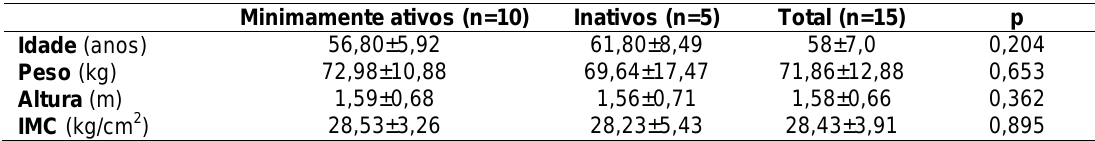
Tabela 1. Caracterização e homogeneidade da amostra Minimamente ativos (n=10)